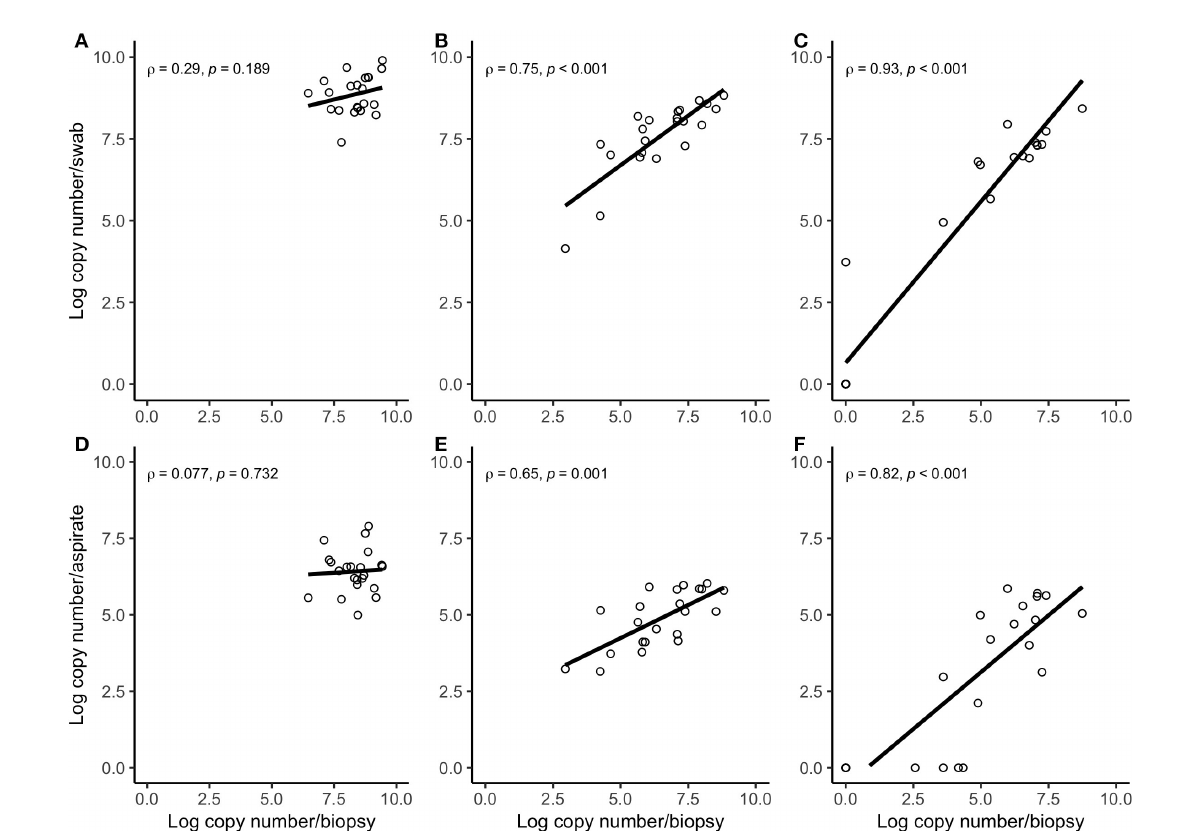
FIGURE3 Spearman correlation plots between the amount (log-transformed copy numbers) of Treponema phagedenis (A) , Treponema medium (B) , Treponema pedis (C) in swabs and biopsies of bovine DD active M2 lesions, and T. phagedenis (D) , T. medium (E) , and T. pedis (F) in aspirates and biopsies of bovine DD active M2 lesions. There were significant correlations between the quantity of T. pedis and T. medium in biopsies and swabs and biopsies and aspirates. There were no significant correlations between the quantity of T. phagedenis, neither in biopsies and swabs nor in biopsies and